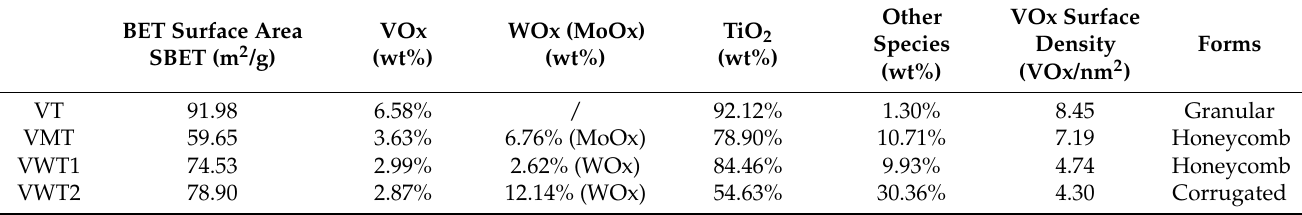
Table 2. Basic information of